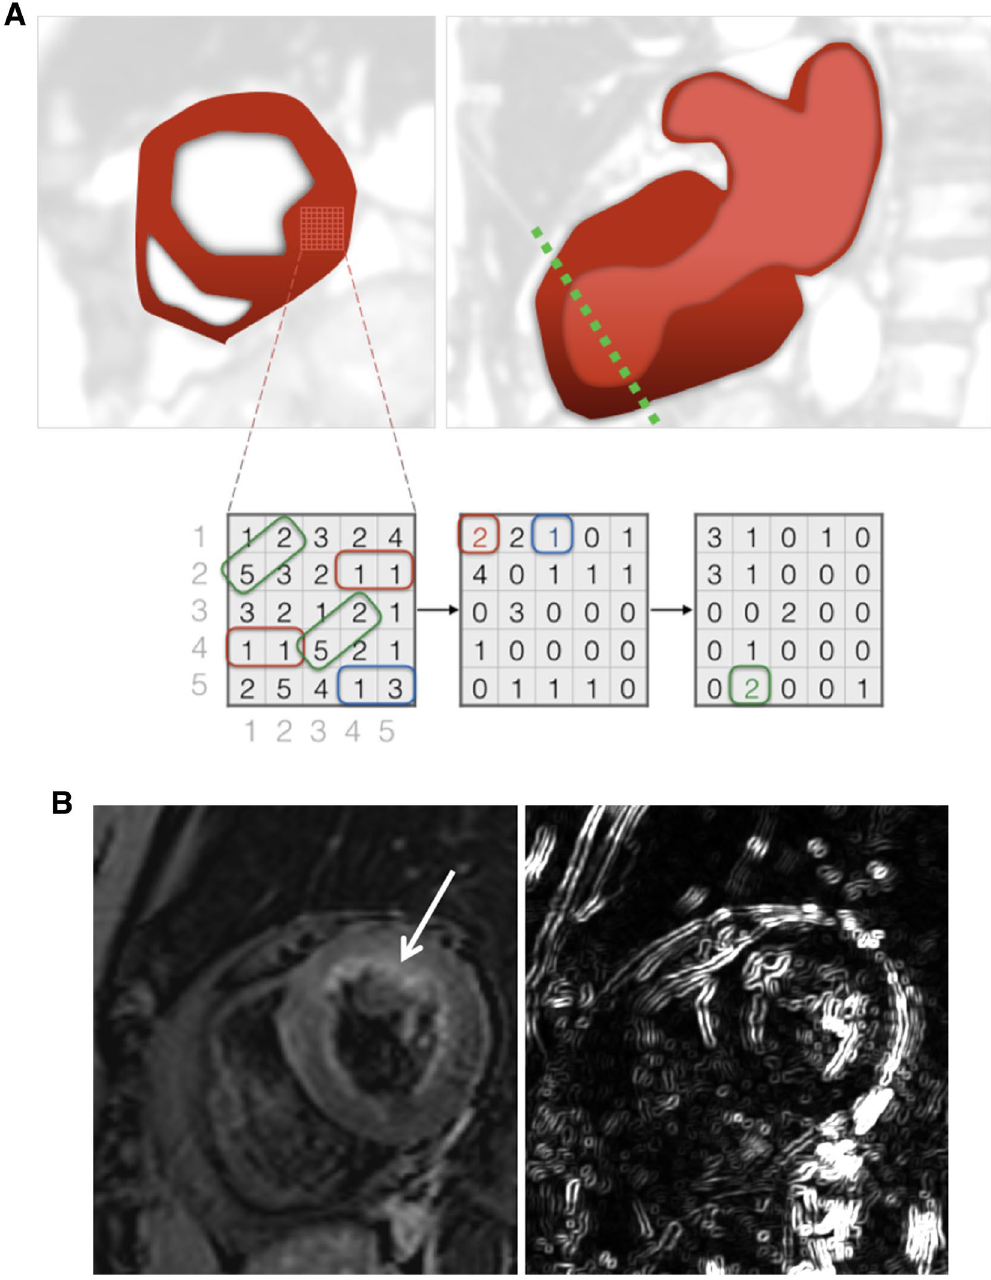
Figure 1. Cardiac Magnetic Resonance Imaging and Texture Analysis. ( A ) Schematic depiction of acute takotsubo syndrome with characteristic ballooning of the left ventricle in two-chamber longitudinal view (top left image) . The dotted line in green marks the plane for short axis cardiac magnetic resonance image acquisition (top right) at the point of maximal ventricular wall abnormality. After placement of a region-of-interest within the myocardium, a matrix of contained pixel intensities is generated (bottom left) . Derived from inter-pixel relationships, various texture analysis features can be computed. Grey-Level co-occurrence matrices (GLCM) for 0° (bottom center) and 45° (bottom right) are shown. Exemplarily, the combination of two consecutive pixels with value ‘1’ is found twice in the signal intensity matrix and therefore marked as ‘2’ in the GLCM (0°) matrix at position row = 1 and colums = 1 (red box). Similarly, two consecutive pixels with value ‘1’ and ‘3’ are found once and therefore marked as ‘1’ in the GLCM (0°) matrix at position row = 1 and column = 3 (blue box). The diagonal runs of values ‘5’ and ‘2’ are found twice in the signal intensity matrix and therefore marked as ‘2’ in the GLCM (45°) matrix at position row = 5 and column = 2 (green box). ( B ) 76-year old female patient with acute onset of takotsubo syndrome with basal oedema ( arrow ) in a fat saturated T2w short axis dark-blood image of the left ventricle. Image on the right depicts the corresponding map of the GLCM S(4,-4)DifVarnc